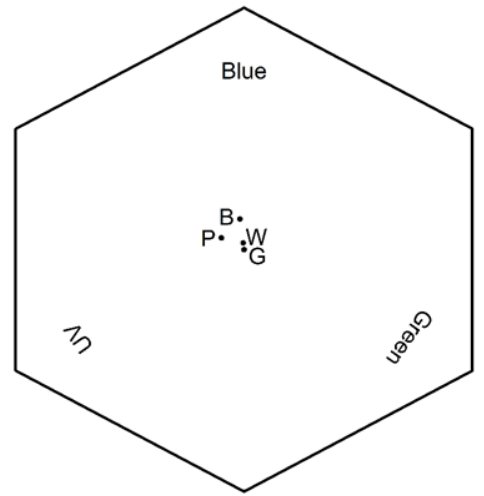
F IGURE 2. Colours of artificial flowers in B. impatiens colour space. W = white, B = blue, and P = purple corolla. G = average colour of the green turf background. The diagram was made according to Chittka (1992) using data on the spectral sensitivities of B. impatiens receptors from Skorupski and Chittka